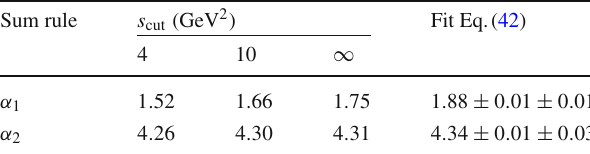
Table 6 Values for the subtraction constants calculated from the sum rule Eq.(29), as for the results of our fits given in Eq.(42), for three different values of s cut in the dispersive integral Sum